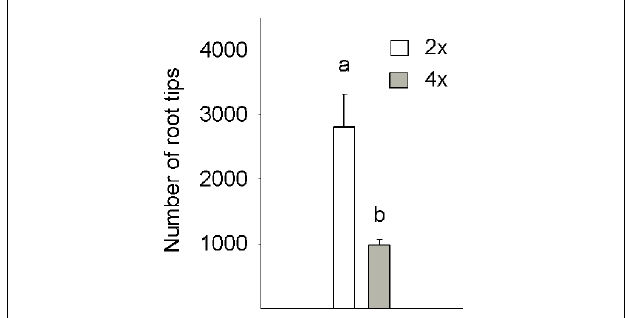
FIGURE 5 | Number of root tips in 6-month-old 2x and 4x CC seedlings grown in greenhouse conditions. Values are the means ± SE of three plants ( n = 3). Different letters indicate significant differences at P < 0.05 using Duncan’s multiple range test.